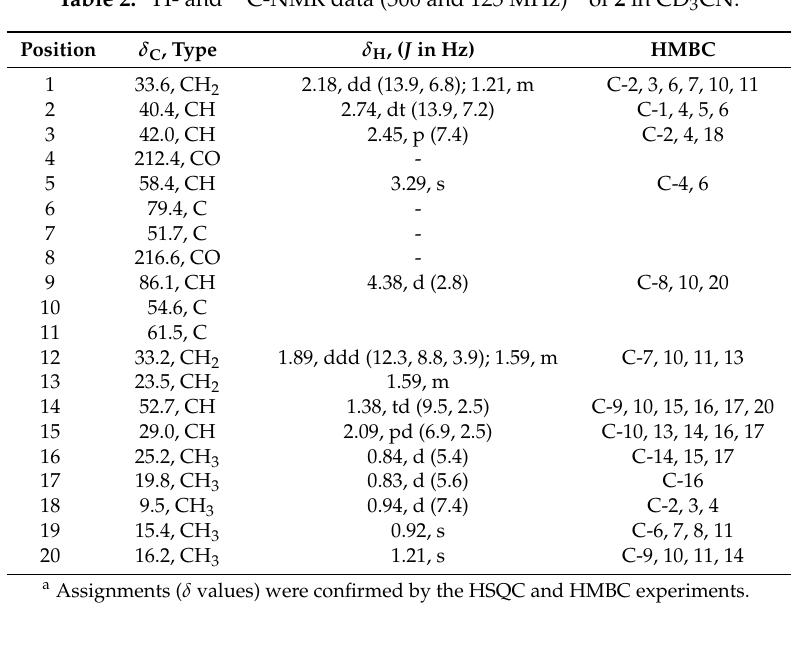
Table 2. 1 H- and 13 C-NMR data (500 and 125 MHz) a of 2 in CD 3 CN.